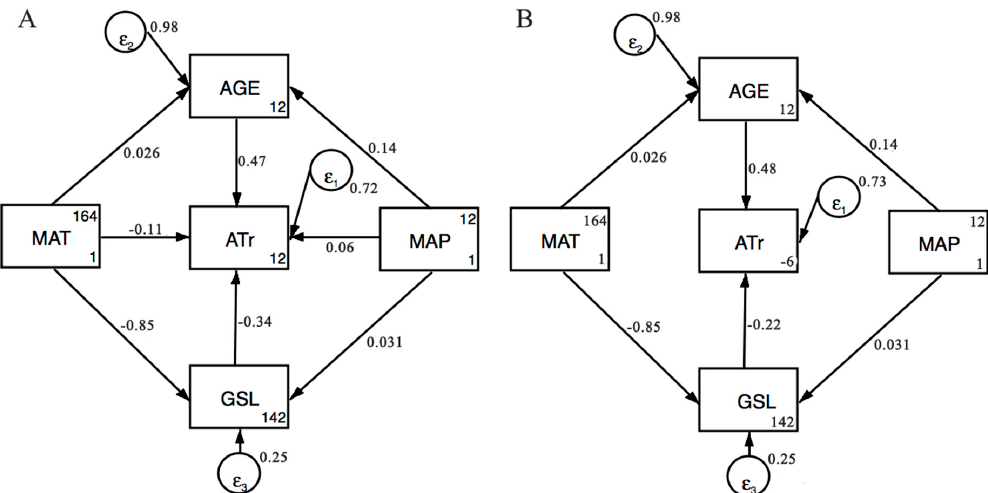
Figure 3. Structural equation models (SEM) for average time of woody biomass residence as determined by climate variables, stand age, and growing season length applied to the 262 woody plant communities. ATr: Average time of biomass residence; AGE: Forest age; GSL: Growing season length; MAP: Mean annual precipitation; MAT: Mean annual temperature; ε i : Error. Directional arrows linking two variables depict direct effects with the standardized path coefficients. ( A ) Chi-square = 0.00, Prob > chi-square = 0.96, AIC = − 615.69, BIC = − 565.733; ( B ) Chi-square = 2.58, Prob > chi-square = 0.462, AIC = − 617.117, BIC = − 574.297.